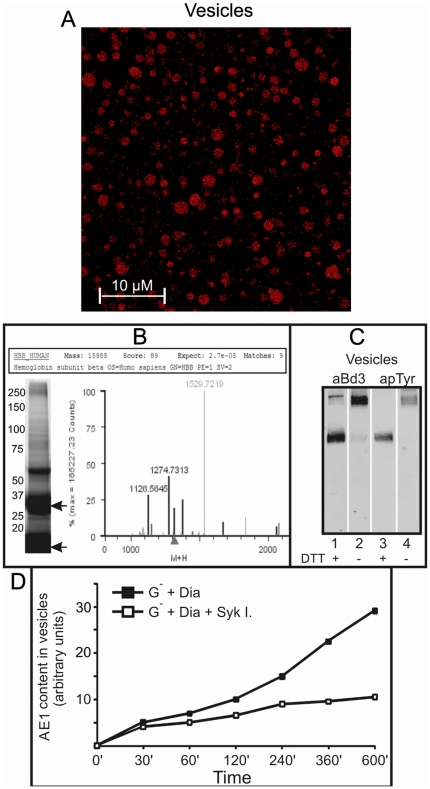
Vesicle characterization.A. Confocal image of isolated vesicles using hemichrome auto-fluorescence (excitation 488 nm, emission 630–750 nm). Bar: 10 µm. B. SDS PAGE of isolated vesicles and mass spectrometry identification of haemoglobin in the two most intense gel bands (indicated by the arrows). C. Corresponding western blot with anti AE1 (aBd3) (lanes 1 and 2) and anti-phosphotyrosine (apTyr) (lanes 3 and 4) antibodies under reducing (DTT) and non reducing conditions. D. Quantification of AE1 contained in vesicles released from G6PD deficient RBCs (G−). Quantification of AE1 was performed by IR fluorescence detection of anti-phosphotyrosine and anti-band 3 western blots (Odyssey, Licor, USA) with Odyssey V3.0 software and expressed as fluorescence arbitrary units. RBCs were treated with 0.25 mM diamide (dia) in presence or absence of Syk inhibitors 10 µM (Syk I.) at different incubation times (0–600 minutes). Values are means of 3 experiments. The changes caused by Syk inhibitors (after 120 minutes) were significant (p<0.01).